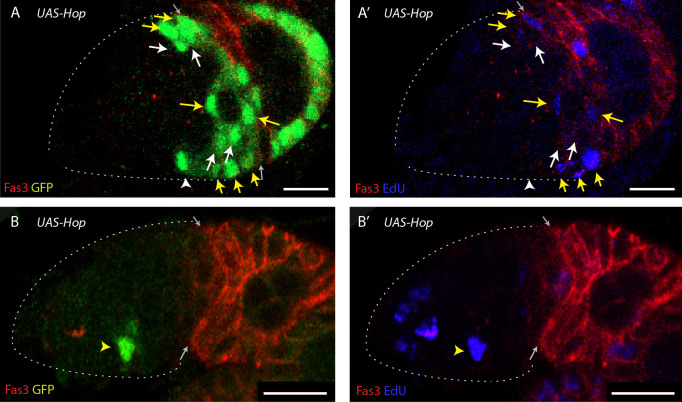
JAK-STAT pathway promotes division of FSCs and cells in EC territory.(A, B) EdU (blue) incorporation into MARCM FSC lineages expressing UAS-Hop 6d after clone induction with anterior border of Fas3 (red) marked (gray arrows), showing (A, B) GFP and (A’, B’) EdU channels separately. (A) The proportion of all GFP-positive FSCs (white and yellow arrows) that incorporated EdU (yellow arrows) was higher than for controls and (B) there were sometimes GFP-positive cells in EC locations that incorporated EdU (yellow arrowhead), which are never seen for control MARCM lineages. All scale bars are 10 μm.